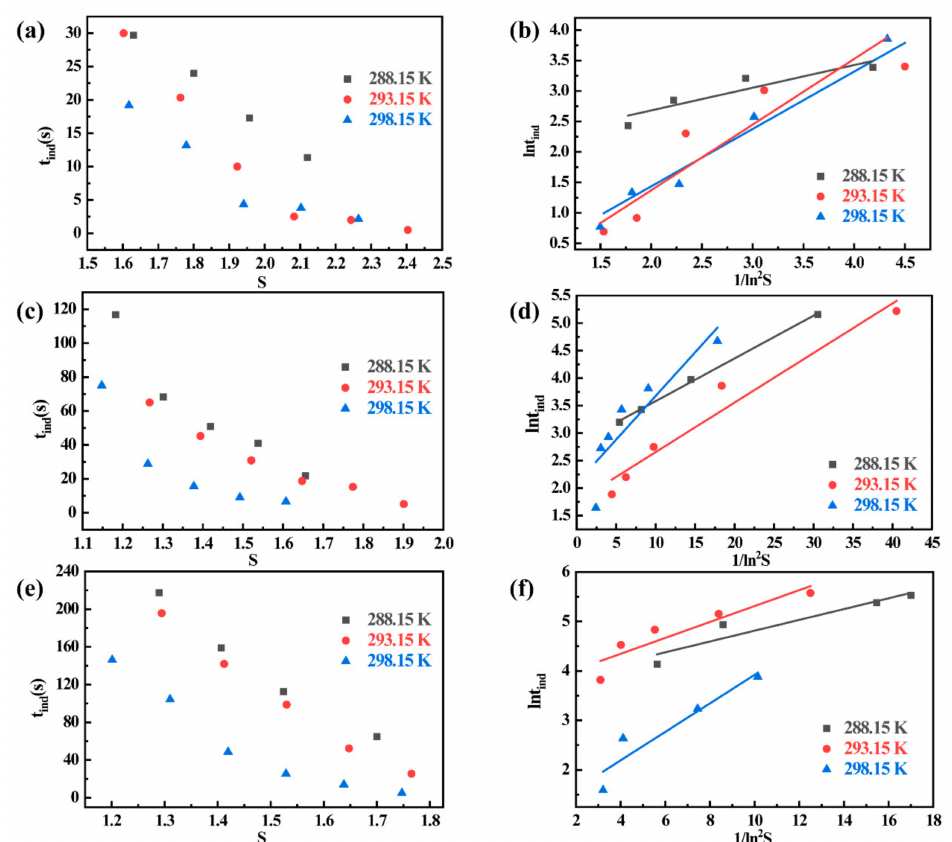
Figure 3. ( a ) Relationship between supersaturation and induction period at different temperatures ( x c = 0.1169). ( b ) Relationship between ln t ind and 1/ln 2 S at different temperatures ( x c = 0.1169). The lines are the linear fit curve of ln t ind and 1/ln 2 S . ( c ) Relationship between supersaturation and induction period at different temperatures ( x c = 0.1707). ( d ) Relationship between ln t ind and 1/ln 2 S at different temperatures ( x c = 0.1707). The lines are the linear fit curve of ln t ind and 1/ln 2 S . ( e ) Relationship between supersaturation and induction period at different temperatures ( x c = 0.2359). ( f ) Relationship between ln t ind and 1/ln 2 S at different temperatures ( x c = 0.2359). The lines are the linear fit curve of ln t ind and 1/ln 2 S